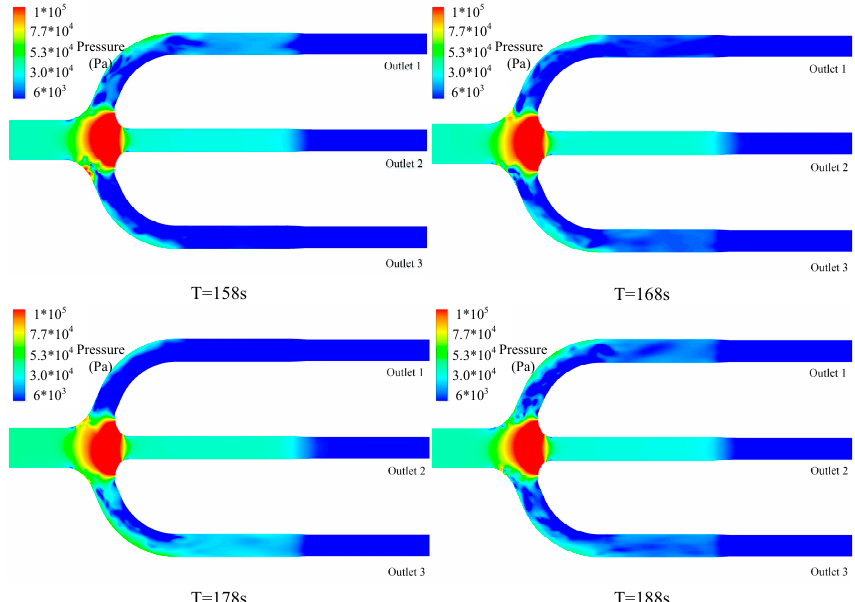
Figure 9. Distributions of pressure at different times (original model).